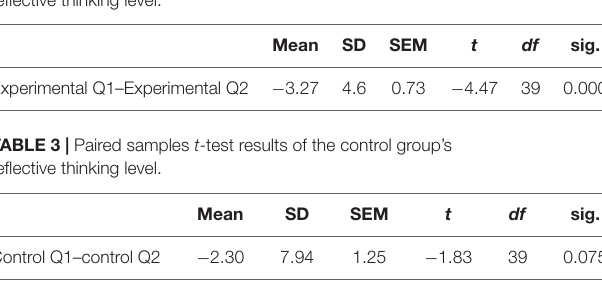
TABLE 4 | Descriptive statistics and t -tests results of both groups in the second administration of the Reflective Thinking (RT) Questionnaire. Groups N Sig Experimental